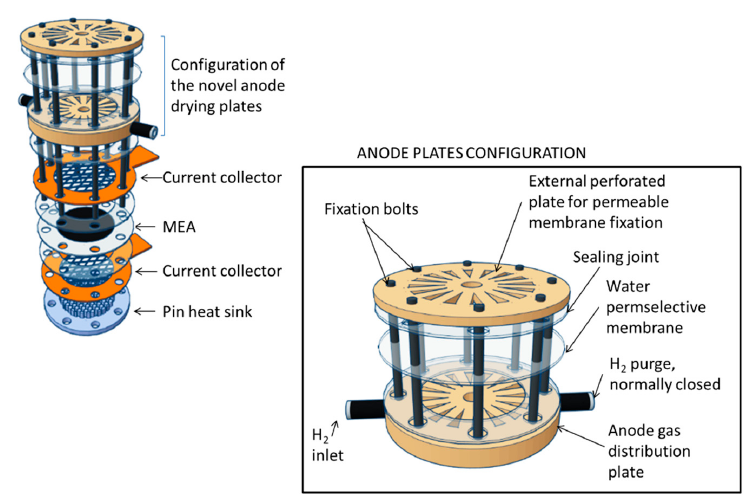
Energies 2020 , 13 , x FOR PEER REVIEW 5 of Figure 2. Exploded view of the passive air-breathing single PEM fuel cell based on WO2015025070A1. Inset: detail of the anode plates to fix the water permselective membrane for passive water management.